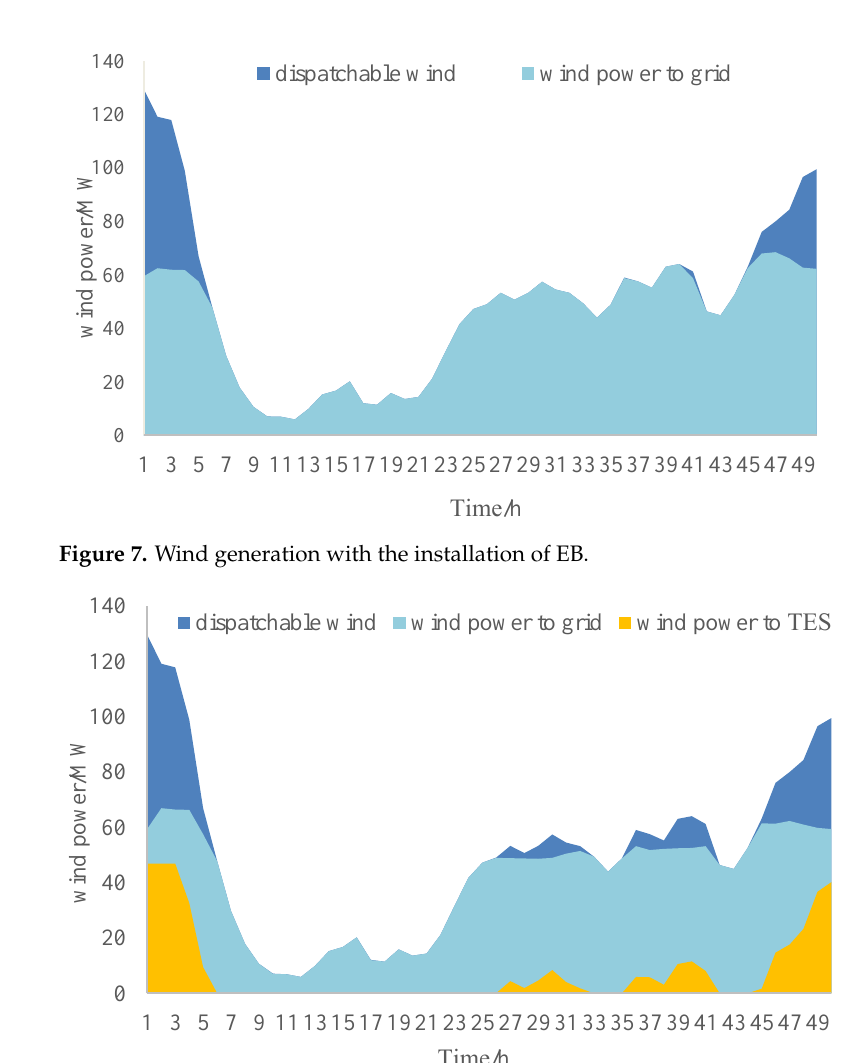
Figure 8. Wind generation with the installation of